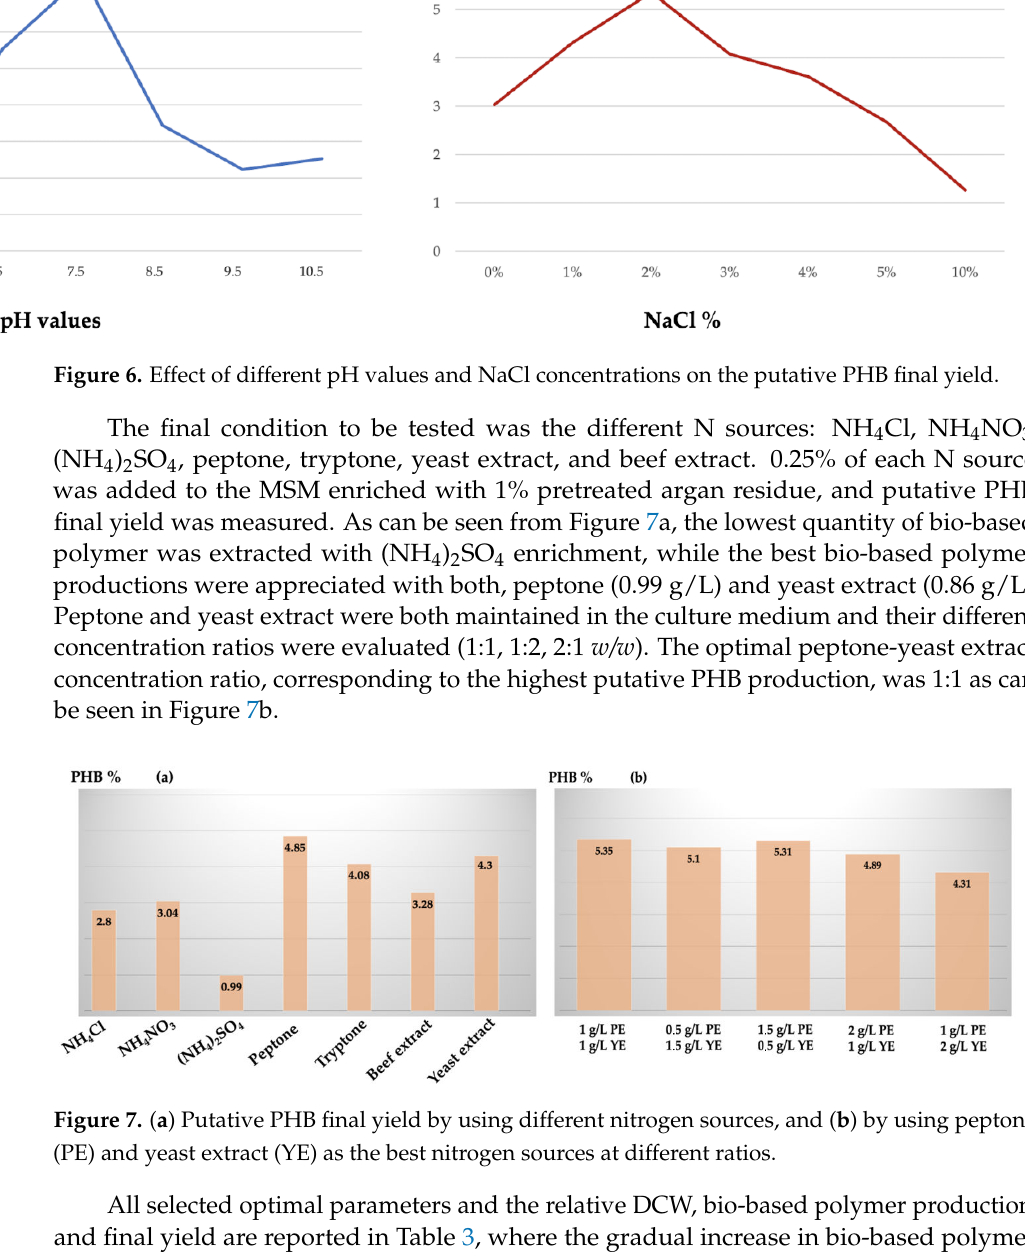
Table 3. Gradual increase in DCW and putative PHB production of the species 1B in 50 mL culture with selected optimal growth parameters .